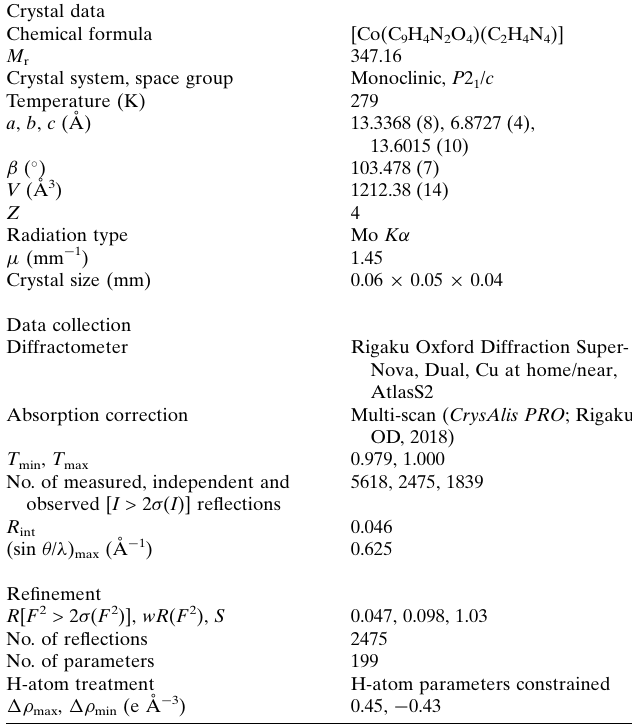
Computer programs: CrysAlis PRO (Rigaku OD, 2018), SHELXT (Sheldrick, 2015 a ), SHELXL (Sheldrick, 2015 b ) and OLEX2 (Dolomanov et al. , 2009).